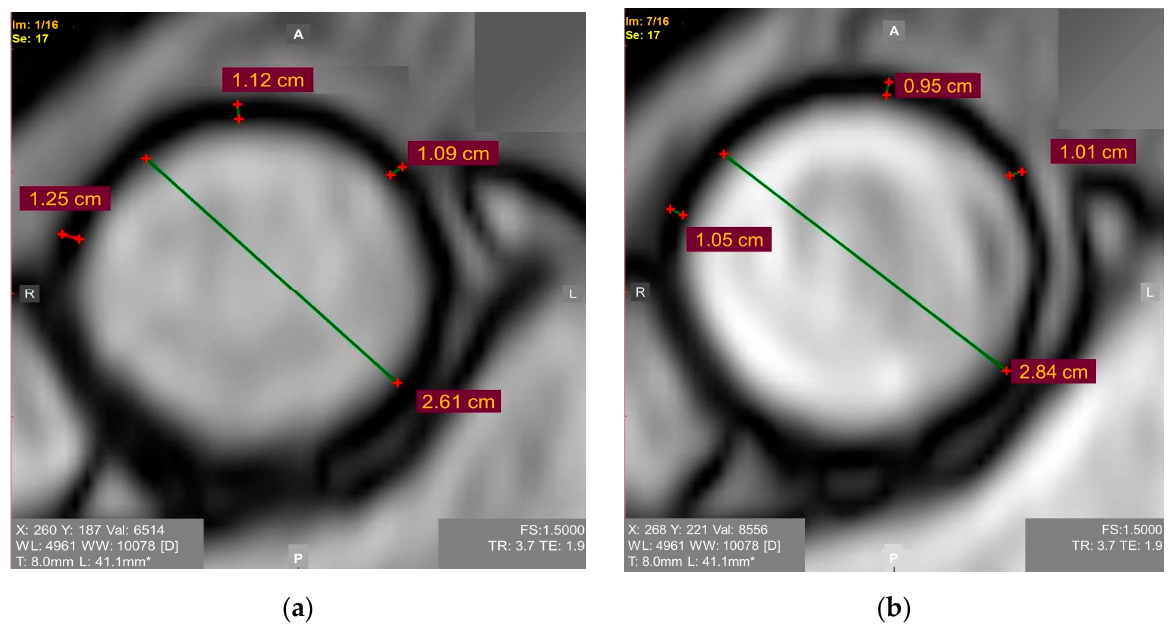
Figure 1. ECG-synchronized magnetic resonance aortography images used for Young’s modulus calculation in the ascending aorta: ( a ) Diastole. Mean diastolic aortic wall thickness = 1.15 mm; ( b ) Systole. Mean systolic aortic wall thickness = 1.05 mm.